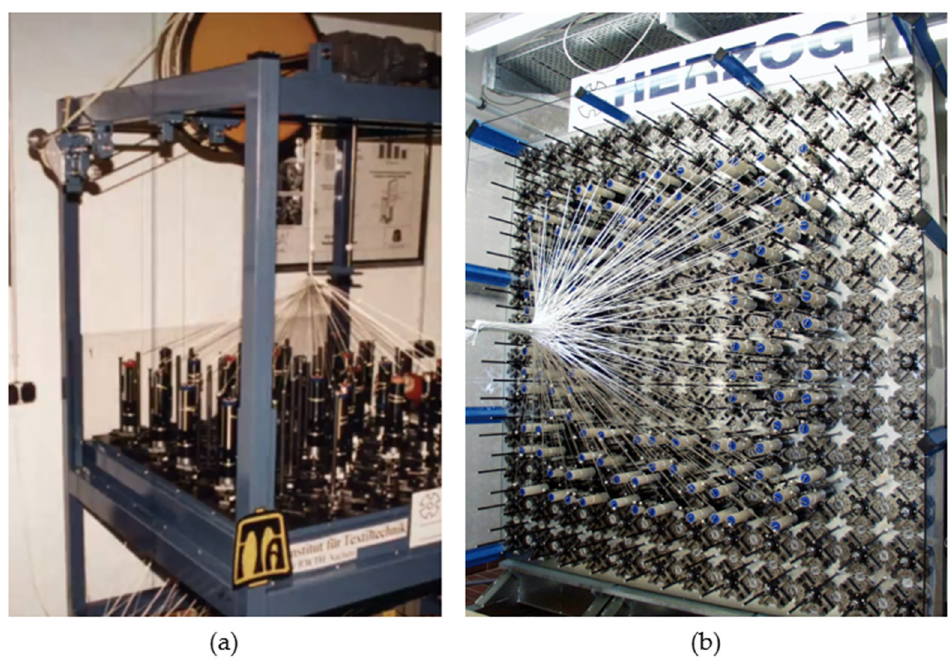
Figure 4. Previous generation of 3D braiding machines: ( a ) conventional Herzog 3D packing braiding machine; ( b ) 9-module Herzog 3D rotary braiding machine.